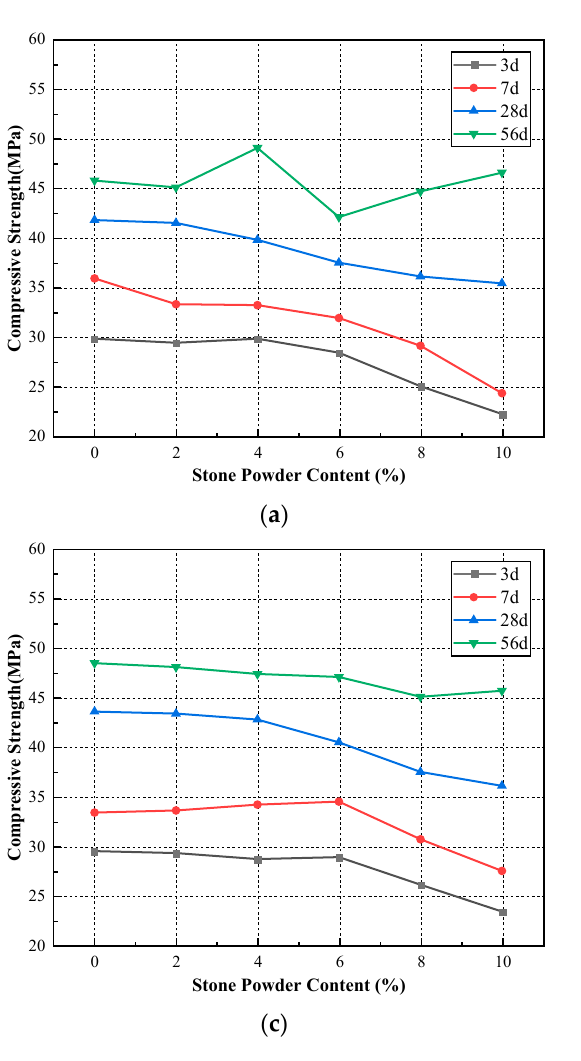
Figure 8. Concrete workability versus fineness modulus and stone powder content curve: ( a ) fineness modulus 2.4; ( b ) fineness modulus 2.5; ( c ) fineness modulus 2.6; ( d ) fineness modulus 2.7; ( e ) fineness modulus 2.8; ( f ) fineness modulus 2.9; ( g ) fineness modulus 3.0; ( h ) river sand concrete.